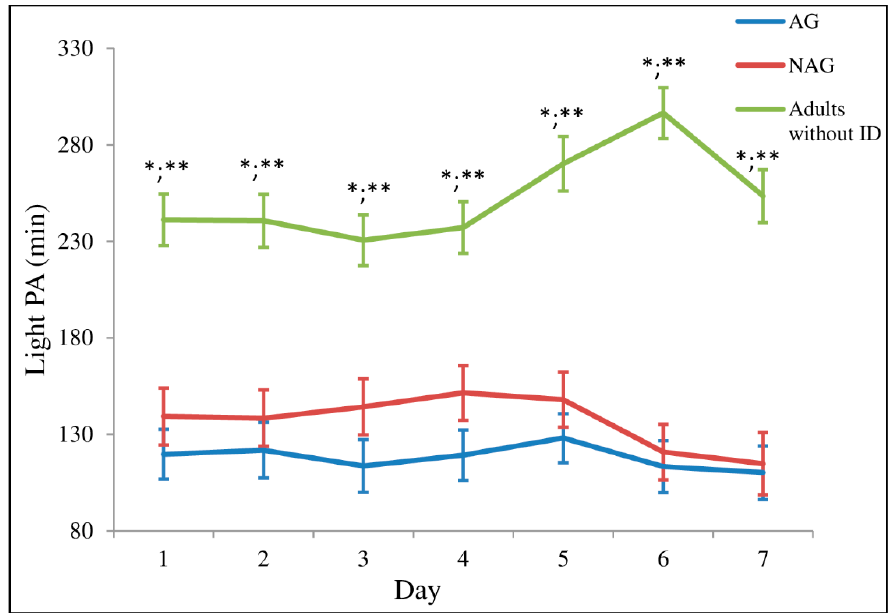
Figure 2. Time spent in light physical activity throughout the week. 1 (Monday); 2 (Tuesday); 3 (Wednesday); 4 (Thursday); 5 (Friday); 6 (Saturday); 7 (Sunday). Values are means (standard error); n = 35 for AG (active group); n = 28 for NAG (non-active group); n = 31 for adults without ID. * Significant difference ( p ≤ 0.05) between adults without ID vs. AG; ** Significant difference ( p ≤ 0.05) between adults without ID vs. NAG.